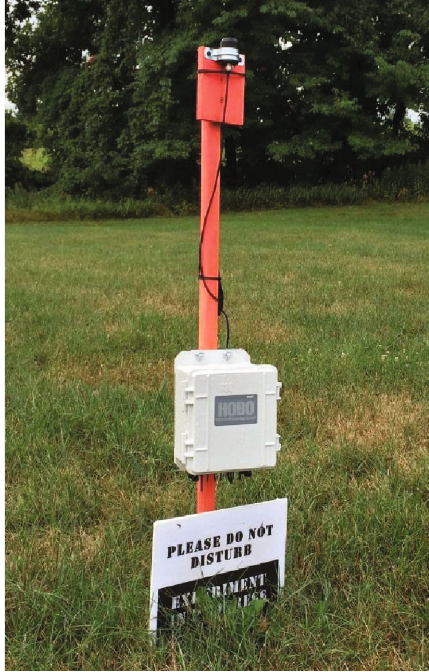
Figure 2: One of two solar irradiance sensors deployed for short timescale